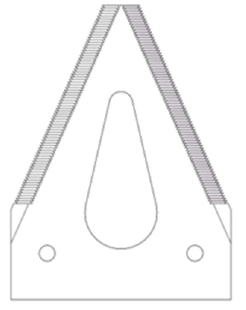
Figure 13. Optimized bionic cutter.